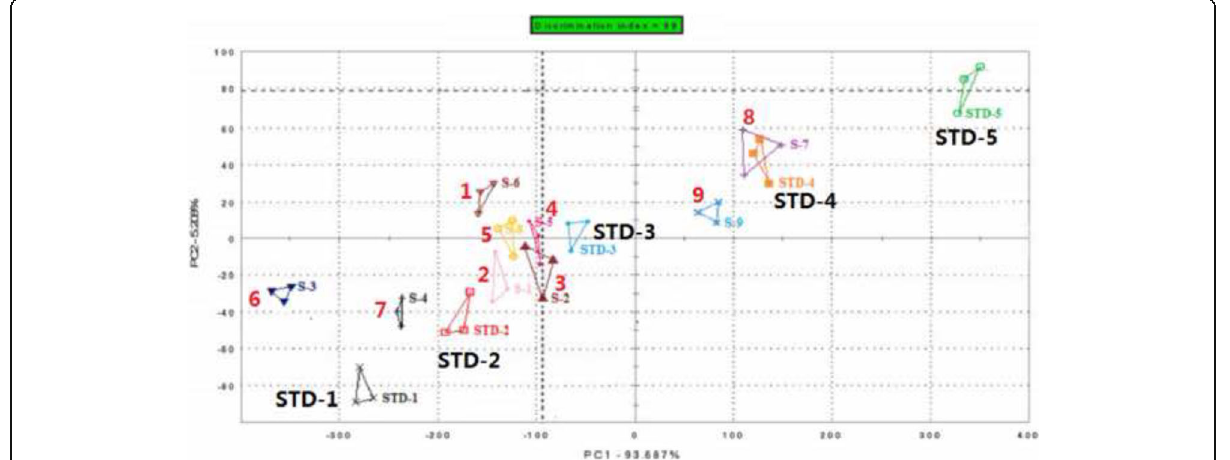
Fig. 3 Principal component analysis (PCA) by e-Tongue